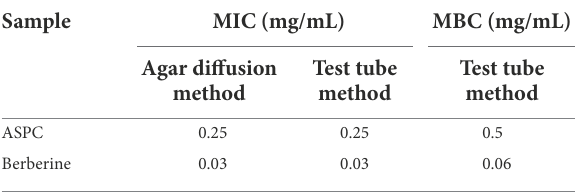
TABLE 3 Inhibitory activities of ASPC and berberine against V. parahaemolyticus .